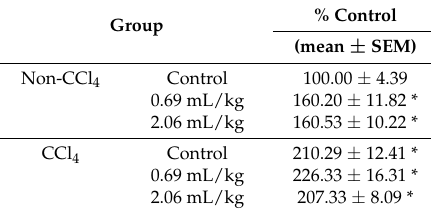
Table 6. Effects of SOD-Like Supreme on plasma AST activity in mice with/without CCl 4 challenge.